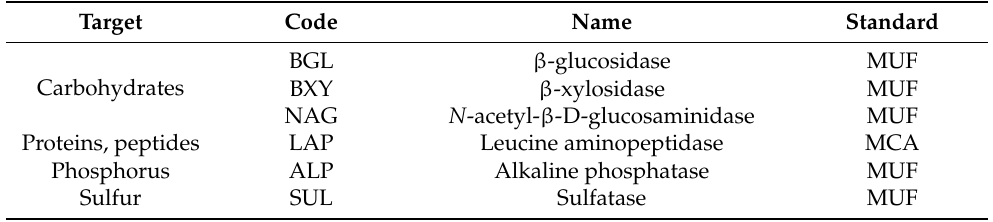
Table 1. Targeted enzymes with an analogue fluorogenic substrate and their respective standards, methylumbelliferyl (MUF) and methylcoumaryl (MCA) amide. Target Code Name Standard BGL β -glucosidase MUF Carbohydrates BXY β